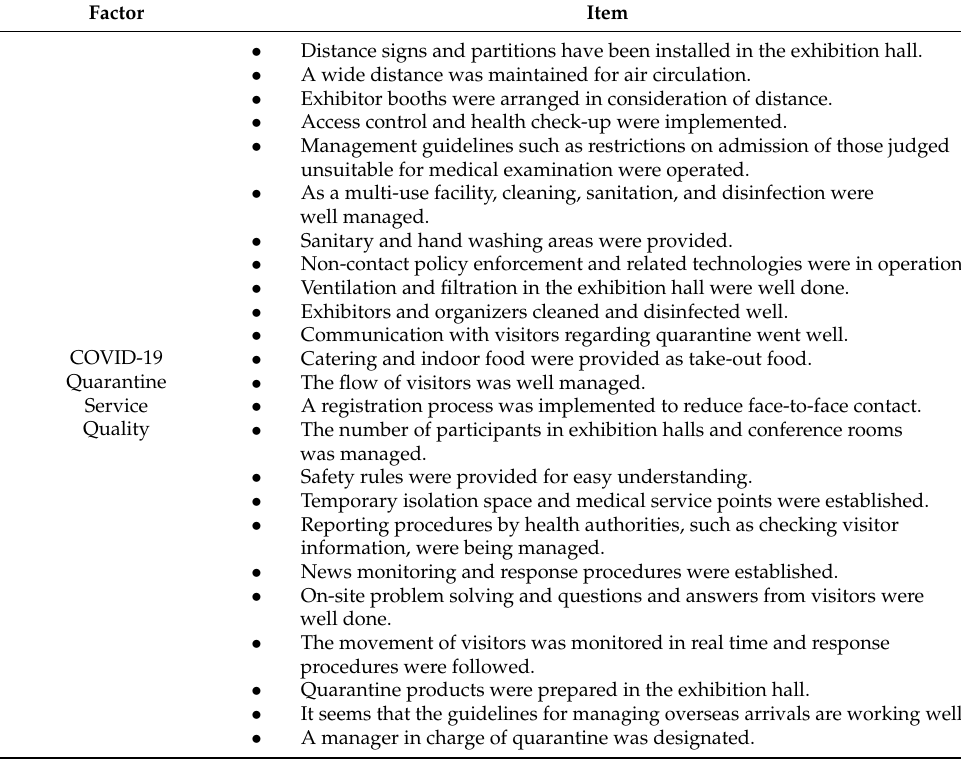
Table 2. COVID-19 quarantine service quality of exhibition hall.